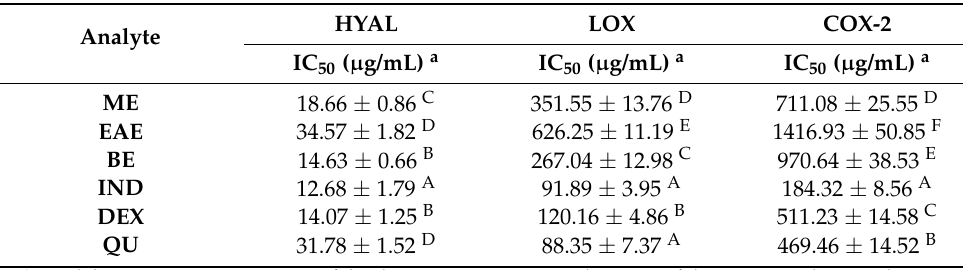
Table 3. Inhibitory activity of G. procumbens leaf dry extracts (ME, EAE, and BE) towards pro- inflammatory enzymes.